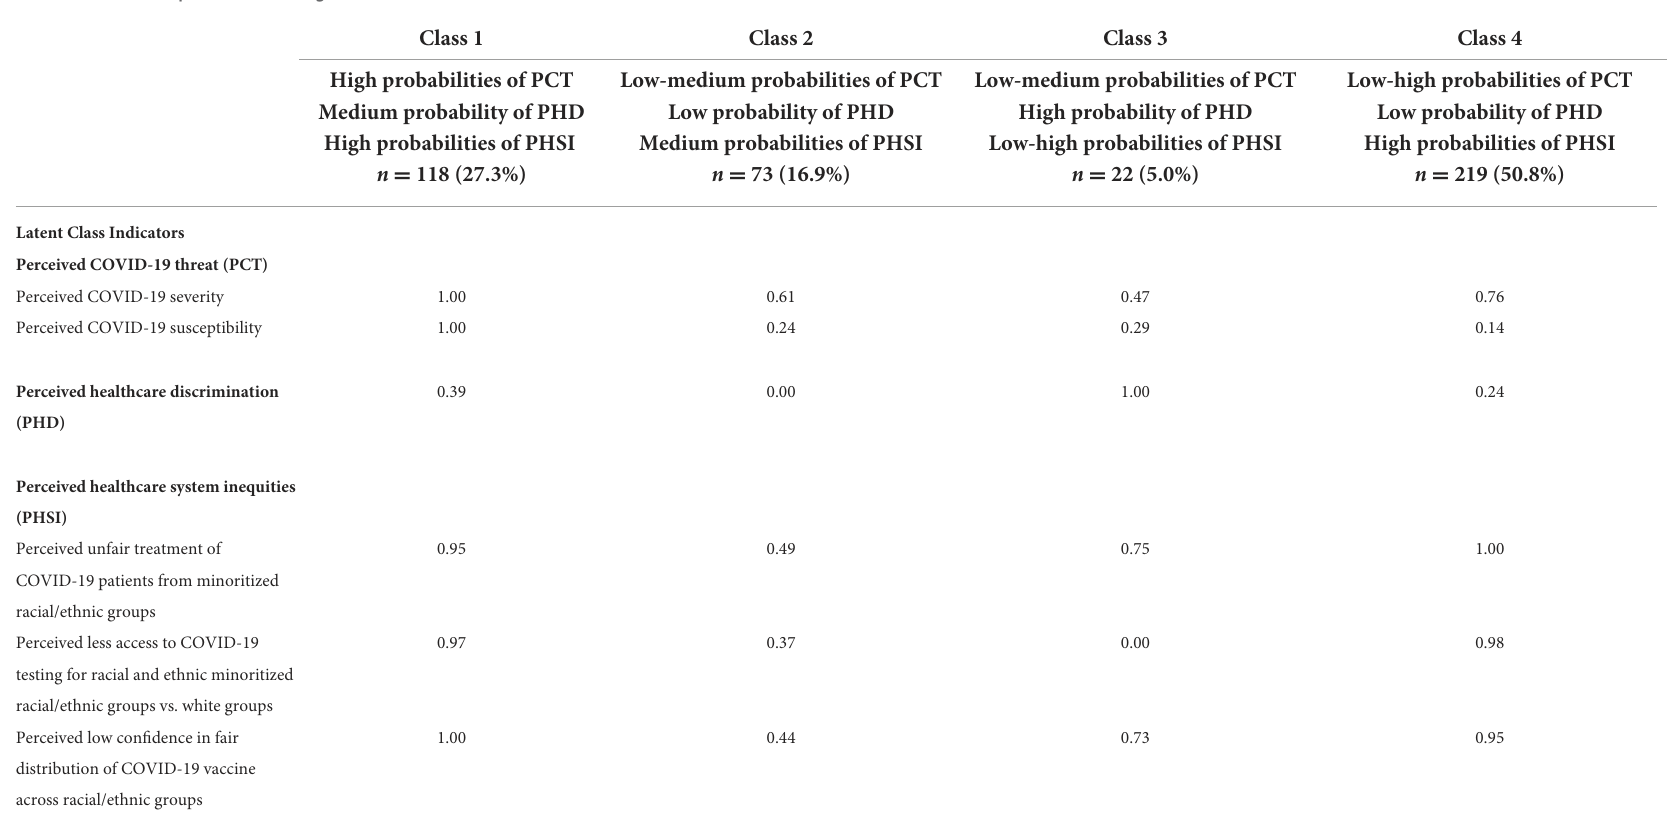
TABLE 2 Estimated probabilities of agreement with latent class